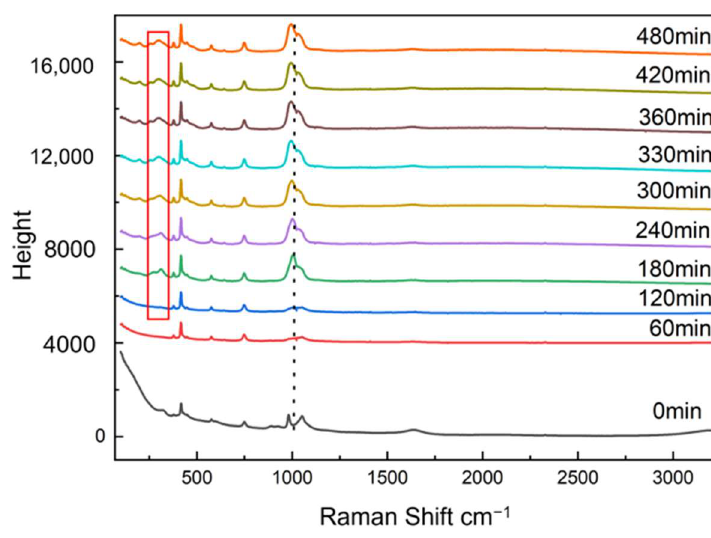
Figure 10. Raman spectra of the precipitates at different reaction